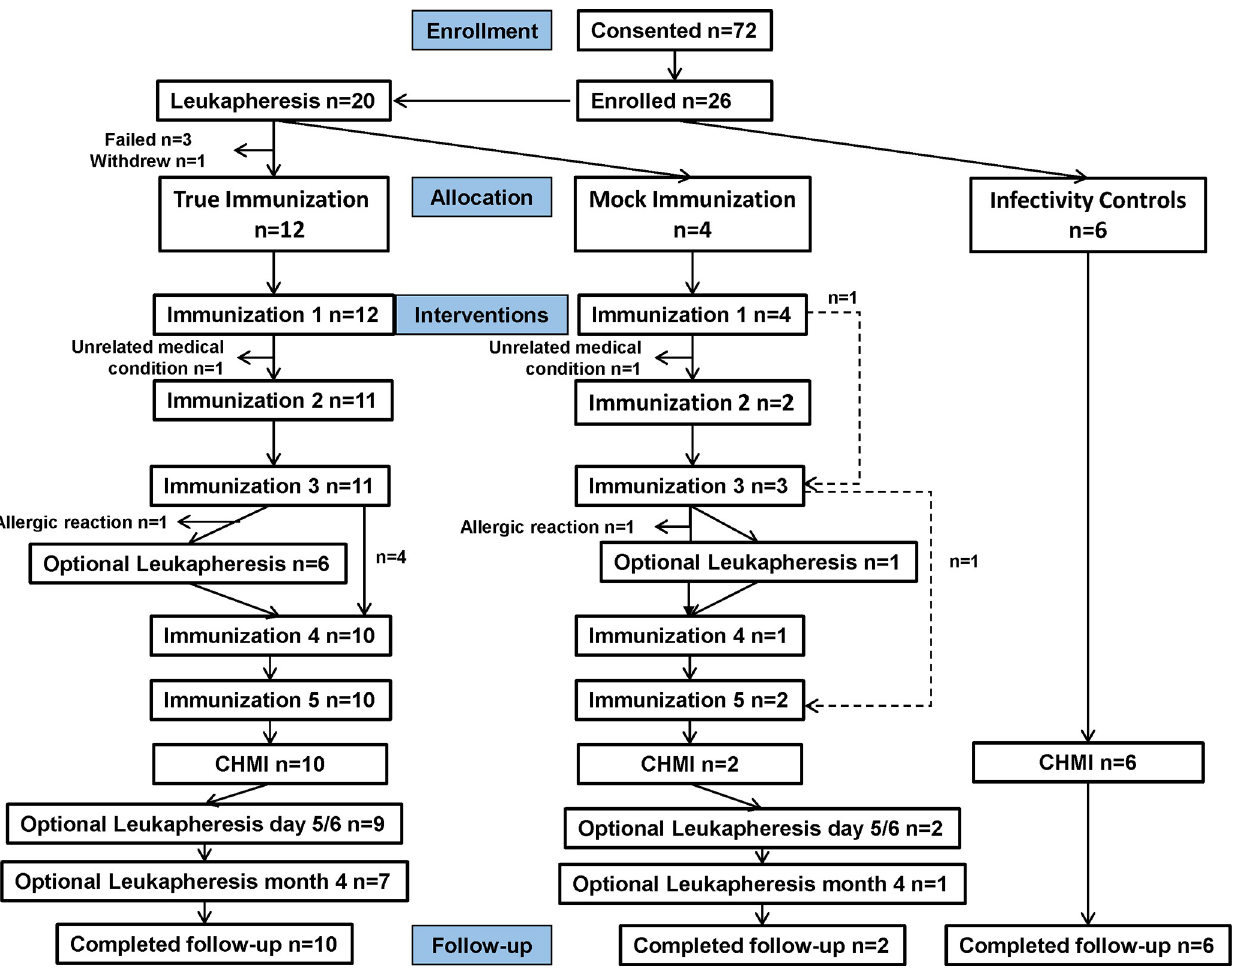
Fig 2. Cohort 2: Flow diagram of immunized and control subjects. Twenty-two subjects met all eligibility criteria and 12 were assigned to the true- immunization group, four were assigned to the mock-immunization group and the remaining six subjects were assigned as infectivity controls.